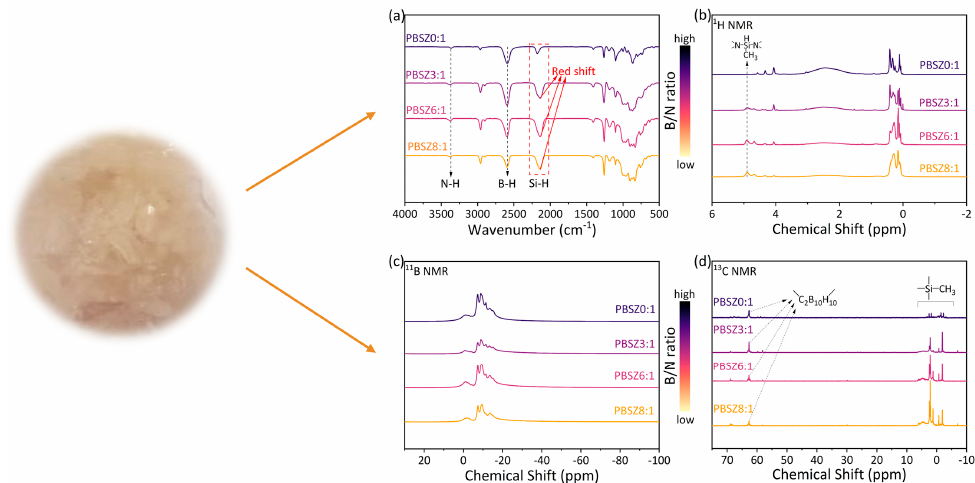
Figure 1. ( a ) FTIR spectra recorded for PBSZ x:y , ( b ) 1 H NMR, ( c ) 11 B NMR, and ( d ) 13 C NMR recorded for PBSZ x:y .